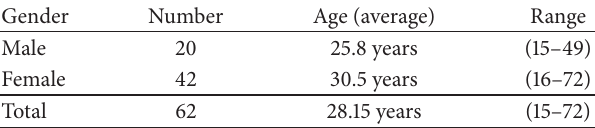
Table 2: Distribution of gender and age in this